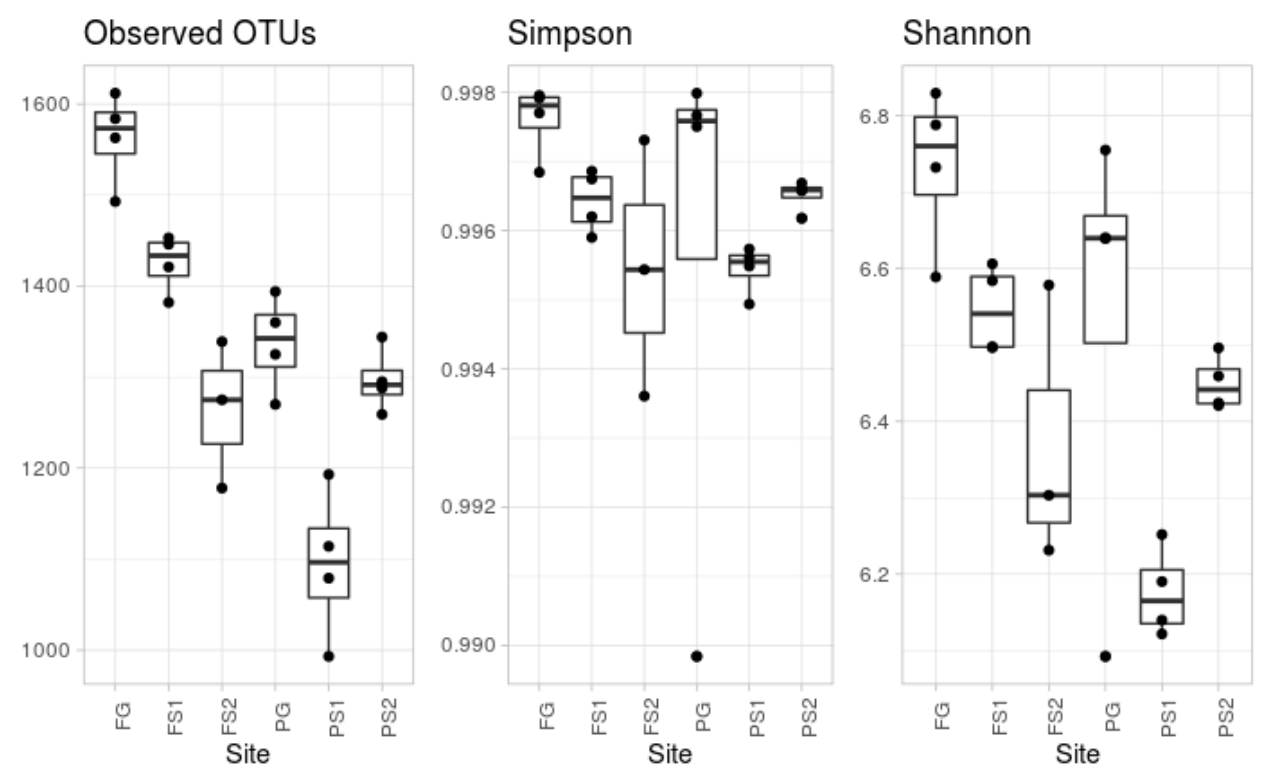
Figure 1. Measured alpha diversity metrics.